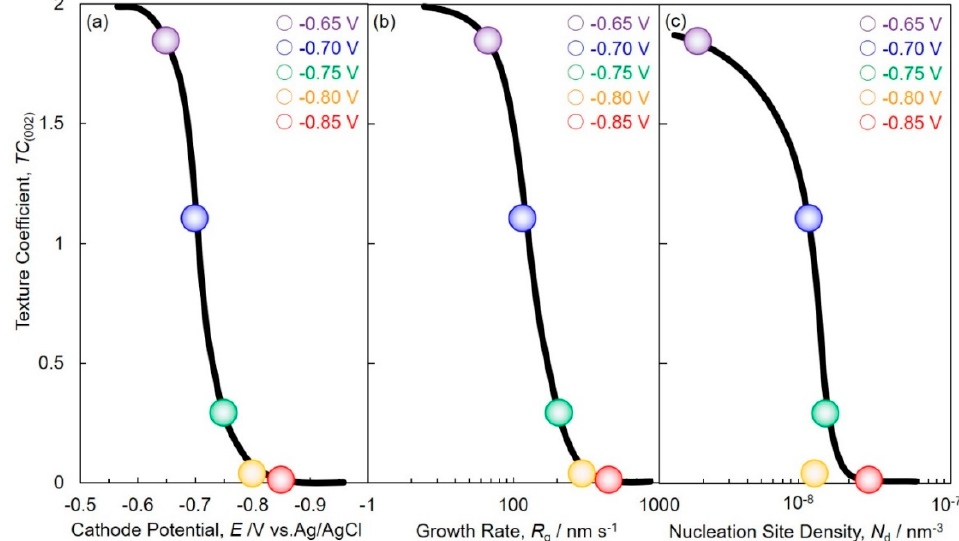
Figure 9. Effect of cathode potential ( a ), growth rate ( b ) and nucleation site density ( c ) on the texture coefficient TC (002) of electrodeposited Co nanowire arrays.